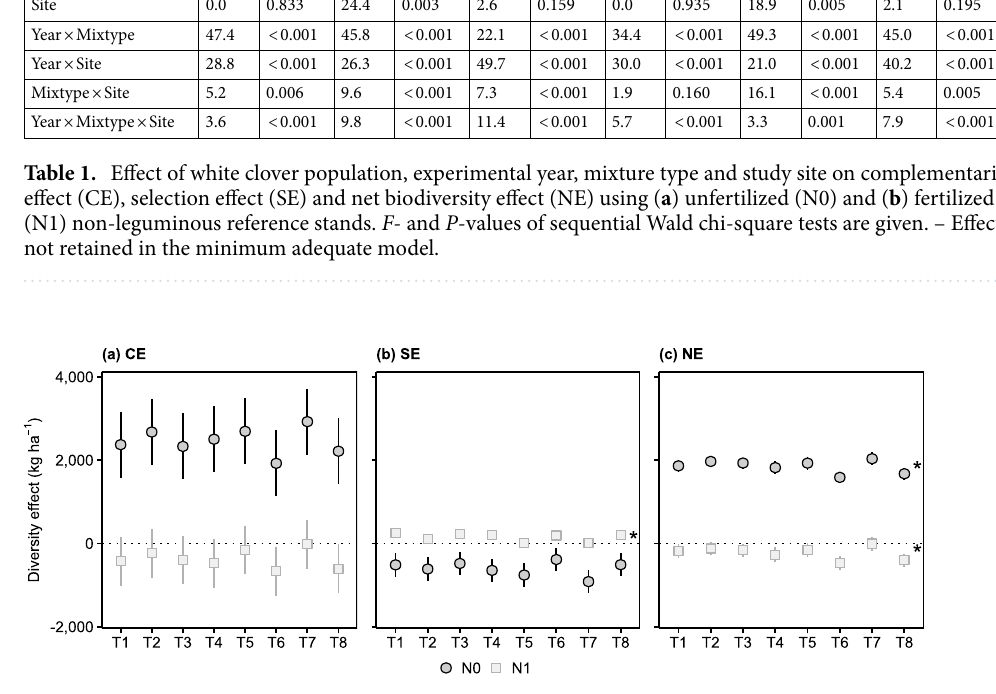
Figure 1. Diversity effects ( a ) complementarity effect (CE), ( b ) selection effect (SE) and ( c ) net biodiversity effect (NE) for different white clover populations (T1–T8) using either unfertilized (N0) or fertilized (N1) non- leguminous pure stands as a reference. Except for *, given values are model predictions with 95% confidence intervals ( n = 120). Asterisks (*) indicate that arithmetic means with standard errors are shown, as the minimum adequate model did not include the effect of population. Pure stand and mixture yield of the white clover populations can be found in Supplementary Table